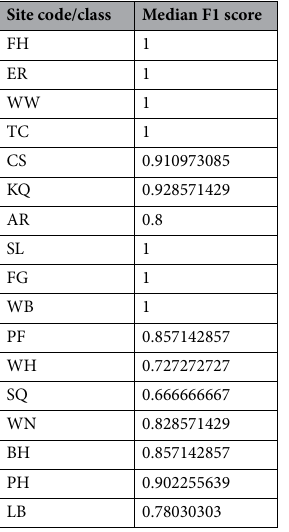
Table 4. Class specific median F1 scores from the random forest classifier.